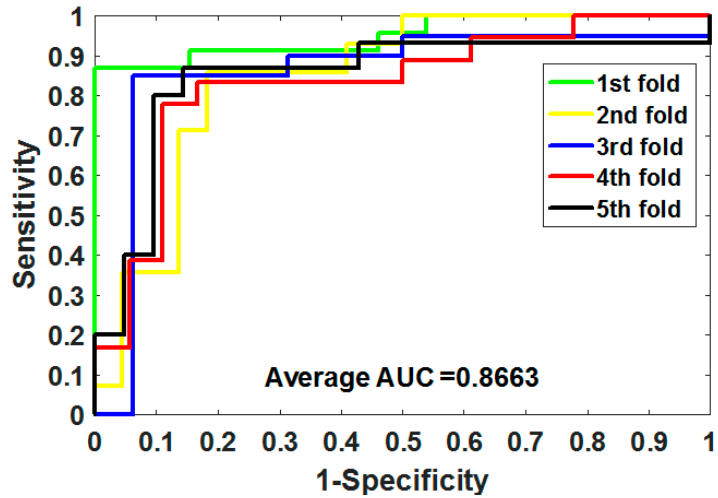
Figure 5. ROC of 5CV mapped by MSPEDTI on nuclear receptor dataset.